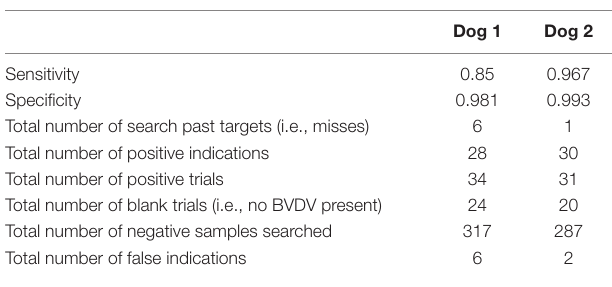
TaBle 2 | individual dog